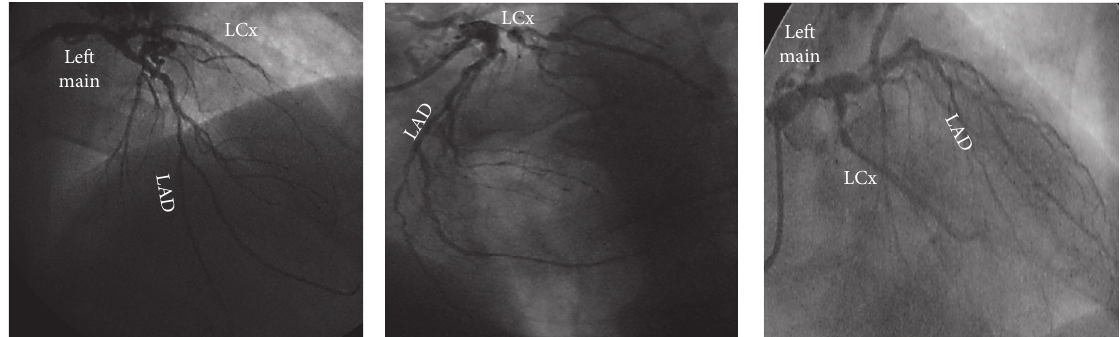
Figure 2: Selective contrast injection in the LCA showing the severe, calcified, and complex multisite obstructive coronary artery disease. LCA: left coronary artery; LAD: left anterior descending; LCx: left